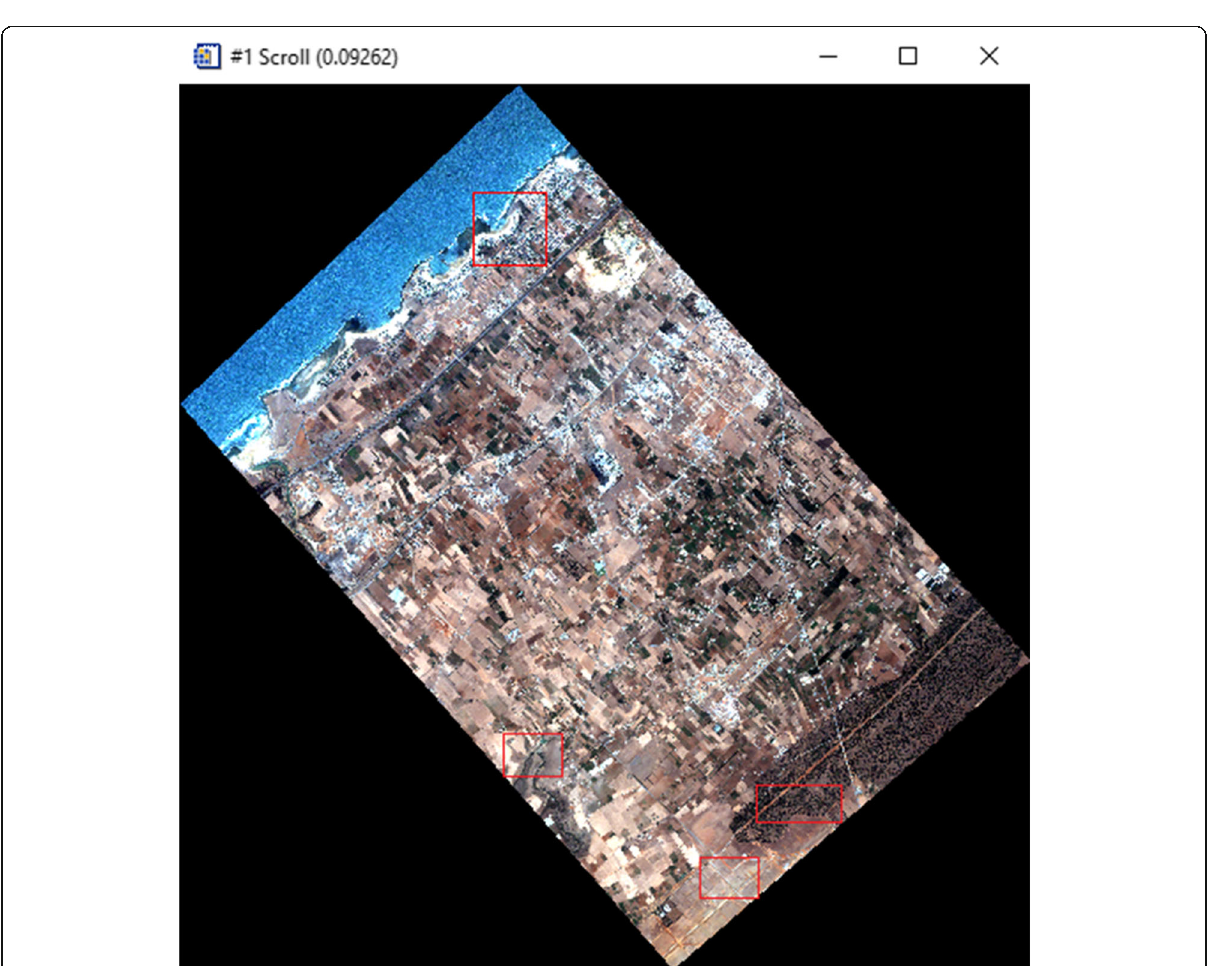
Fig. 1 ®Digital Globe: area of study — QuickBird multispectral image — regions of interest for color image (urban areas, Forêt,